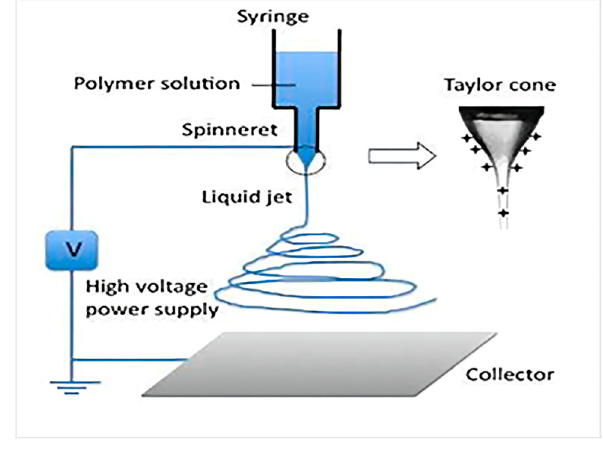
Figure 2. Electrospinning device map.